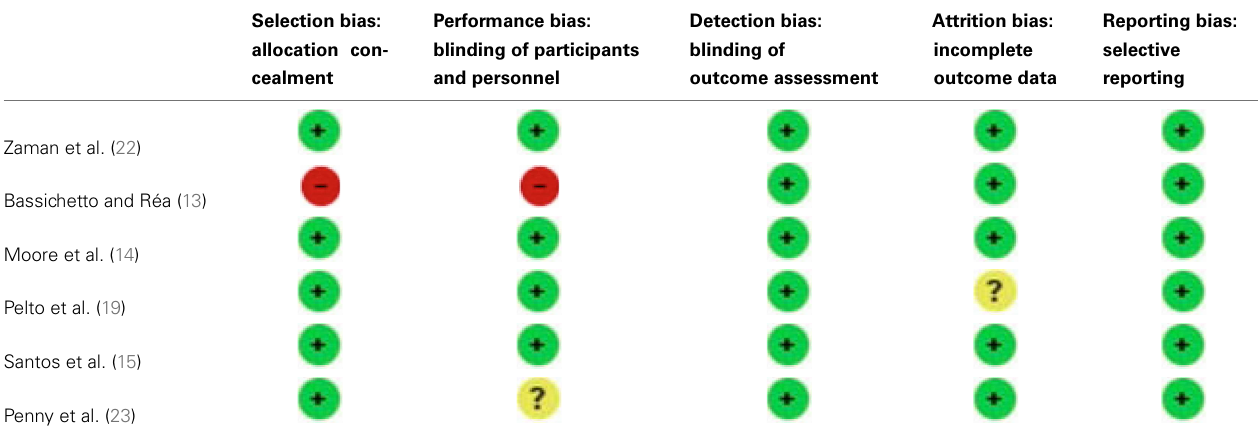
Table 2 | Risk of bias assessment cluster RCTs Cluster RCTs.